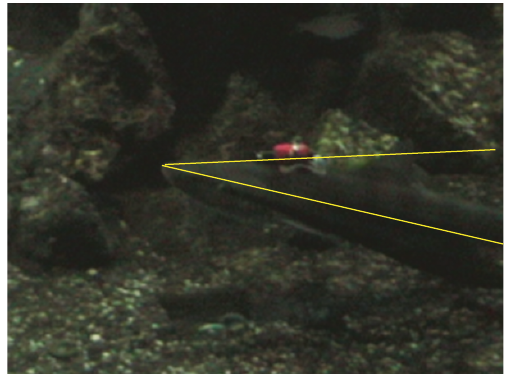
Figure 4: An attachment angle of the data logger on the banded dogfish was 14 ◦ from visual analysis and 13.7 ◦ from the regression line